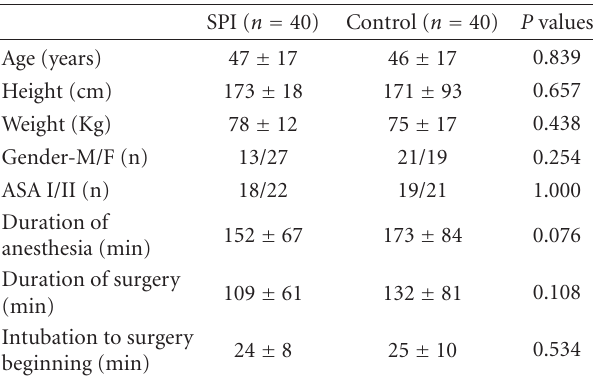
Table 2: Demographic